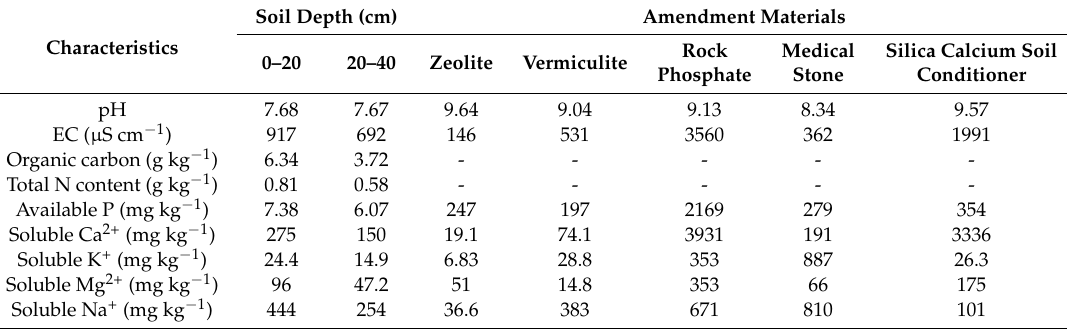
Table 1. Chemical properties of the top 0–20 cm and 20–40 cm soil profile in the experiments and the five mineral amendment